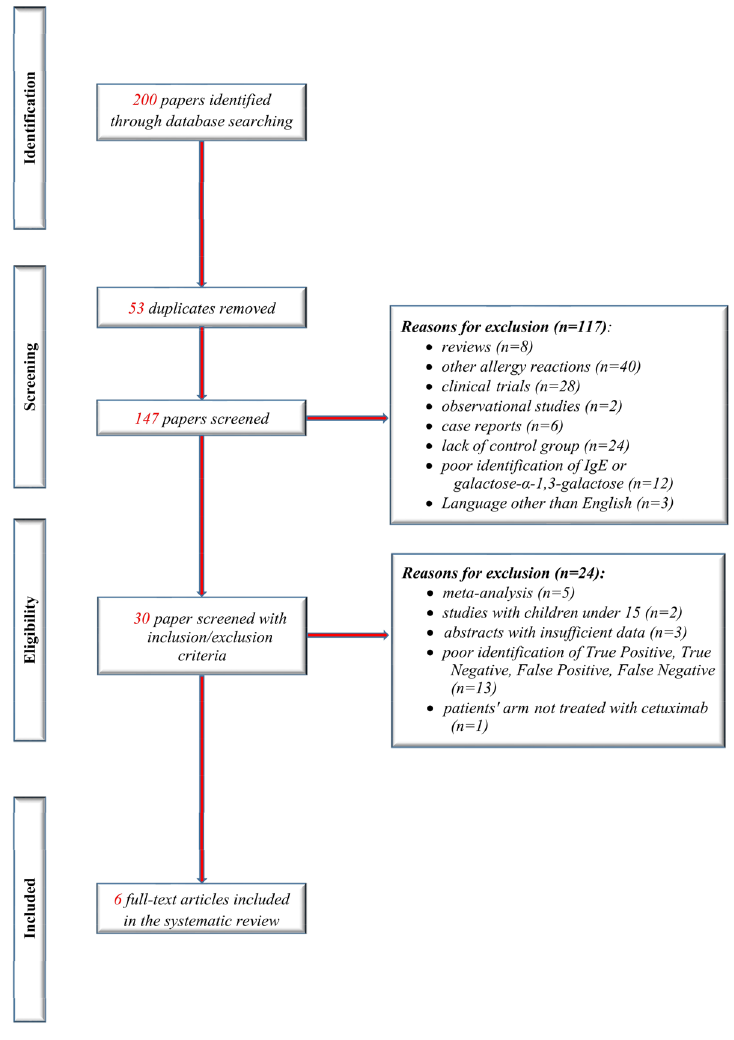
Figure 1. The flowchart of the studies included in this